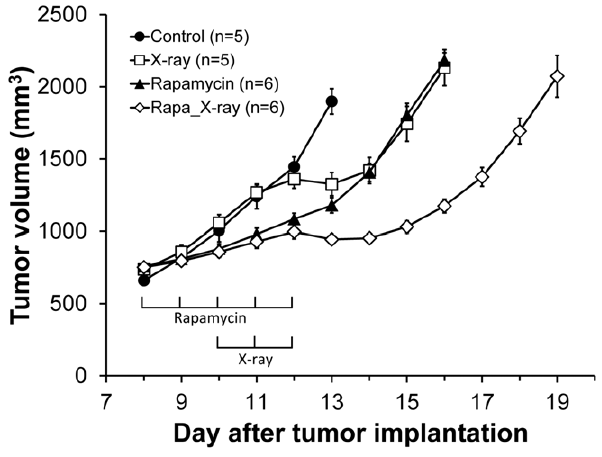
Figure 6. Effect of combination of rapamycin and X-irradiation N on tumor growth. Growth kinetics of SCC tumors implanted in mice ), X-irradiation (5 Gy/day, 3 days, % ), leg, treated with vehicle (control, rapamycin (10 mg/kg/day, 5 days, m ), and rapamycin and X-irradiation ( e ).